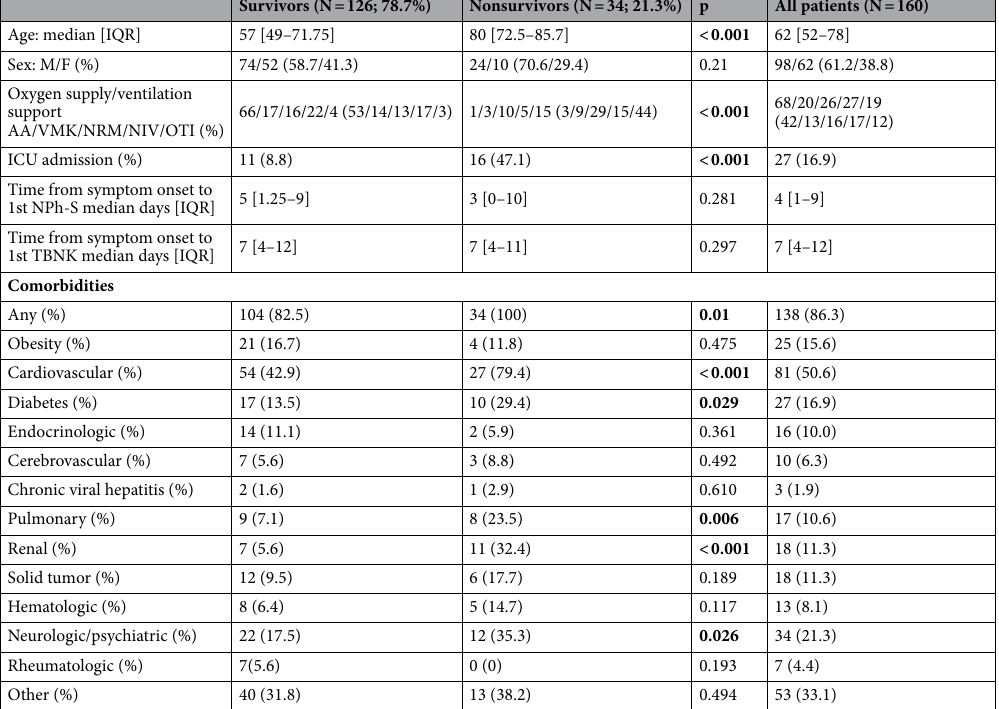
Table 1. Demographic and clinical characteristics of the study population. Statistically significant p values are highlited in bold. Differences between groups were assessed using the Mann–Whitney U test (continuous variable) or the Chi 2 test (categorical variables), as appropriate. A two-sided p value of < 0.05 was considered statistically significant. IQR interquartile range, AA ambient air, VMK Venturi mask, NRM nonrebreather oxygen mask with concentrator, NIV noninvasive mechanical ventilation, OTI Orotracheal Intubation for mechanical ventilation, ICU intensive care unit, NPh-S nasopharyngeal swab, TBNK T-, B-, Natural Killer- lymphocyte subset assessment.